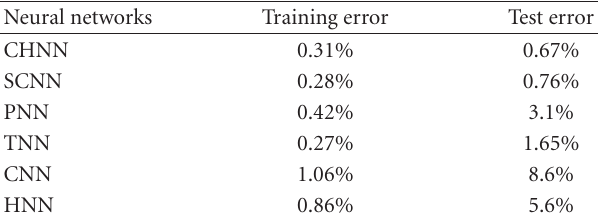
Table 3: Neural Networks’ errors in training and testing